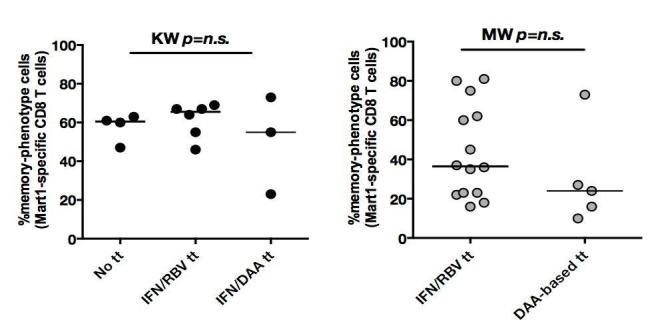
In both cHCV (left) and SVR (right), proportions of memory-phenotype (MP) cells within Mart1-specific populations are not a function of previous drug regimen.